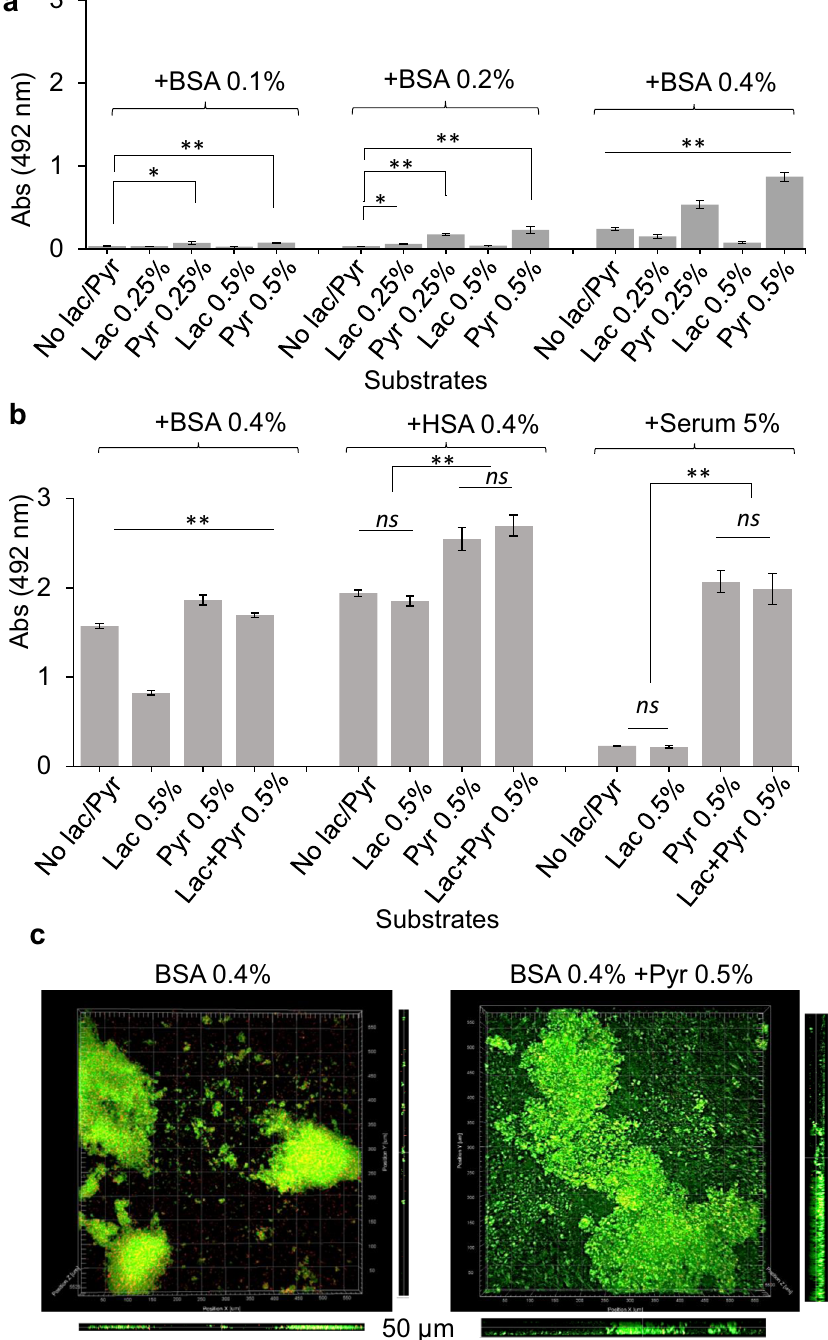
Fig. 1 Synergistic effects of the metabolism of pyruvate, lactate, and serum components on the growth and bio fi lm formation of P. gingivalis . a Bio fi lm assessments show that the utilization of BSA enhances P. gingivalis bio fi lm in a concentration-dependent manner. Pyruvate and lactate as sole carbon and energy sources cannot support P. gingivalis growth and bio fi lm formation, while the combination of BSA-pyruvate and BSA-lactate, respectively, promotes and inhibits bio fi lm formation. b Pyruvate enhances bio fi lm development in combination with human serum albumin (HSA) or human serum, but lactate is not inhibitive to bio fi lm growth neither alone nor in combination with pyruvate. c Images of 24-h bio fi lms were acquired by CLSM. Top and side views show that pyruvate signi fi cantly promotes surface attachment and bio fi lm development by P. gingivalis . Graphs represent mean biomass of bio fi lms ± SE (two biological replicates, in each n = 3) at 48 h, as determined by safranin staining. Bio fi lm biomasses were normally distributed (Shapiro – Wilk test: p > 0.05), and thus analyzed using ANOVA test. Asterisks indicate pairs of signi fi cantly different values (post hoc Tukey ’ s HSD test: * p < 0.05; ** p < 0.01; ns not signi fi